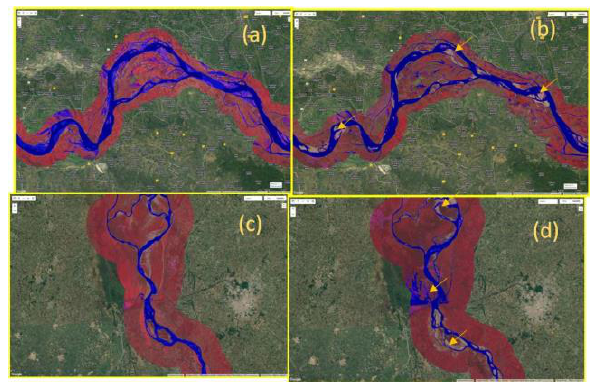
Figure 4. Frequency inundation during Monsoon and